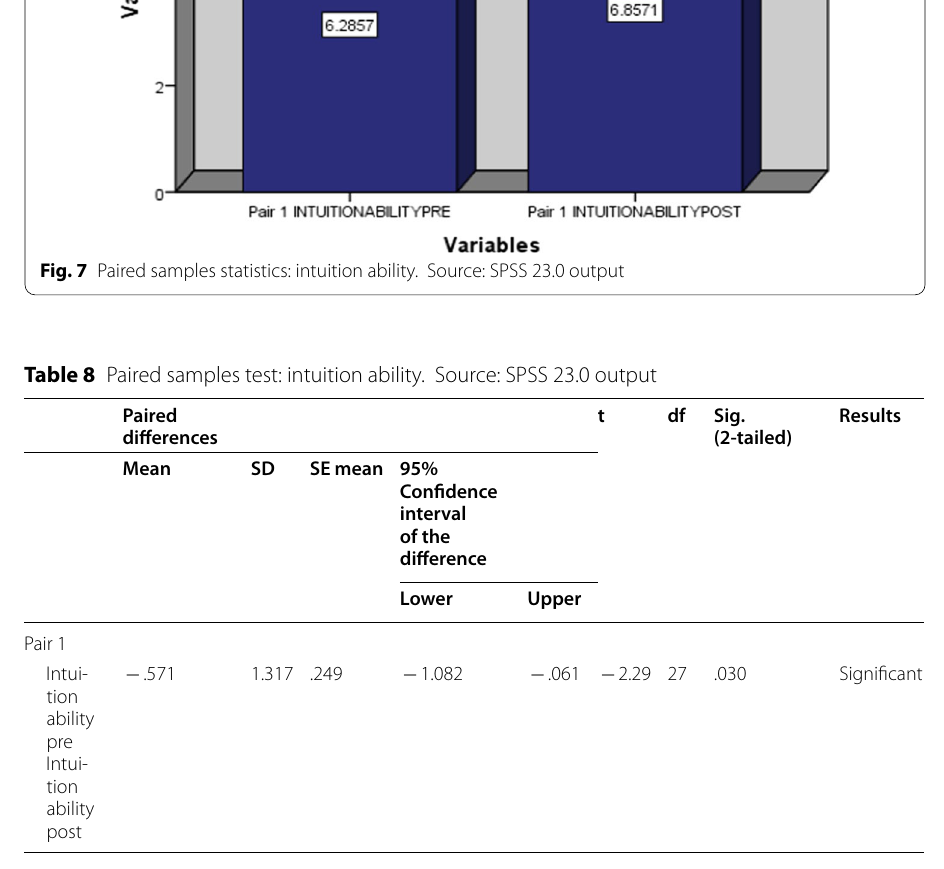
Table 9 Paired samples statistics: blindfold reading/colour identification. Source: SPSS 23.0 output Mean N SD SE mean Pair 1 Blindfold reading pre 1.00 28 .000 .000 Blindfold reading post 6.89 28 2.149